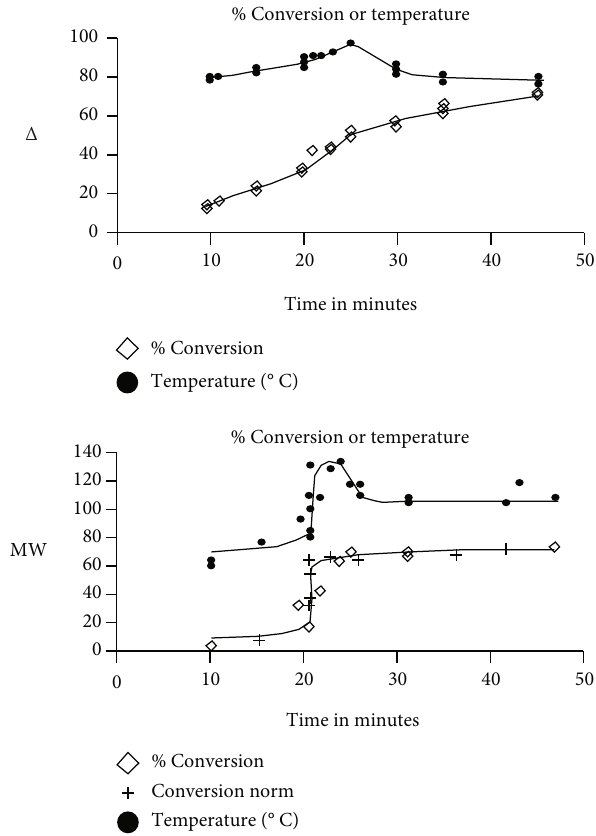
Figure 7: Conversion of methyl methacrylate and evolution of the temperature in the reaction mixture; Δ : by conventional heating; MW: microwave-assisted (reprinted from Chia et al. [48] with permission. Copyright © 1996 John Wiley & Sons, Inc.).